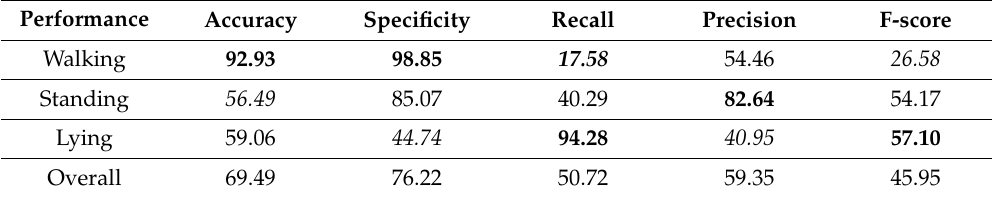
Table 3. Performance of the classification using only the online learning algorithm. In italics is the lowest value and in bold is the highest value across the di ff erent behaviours.